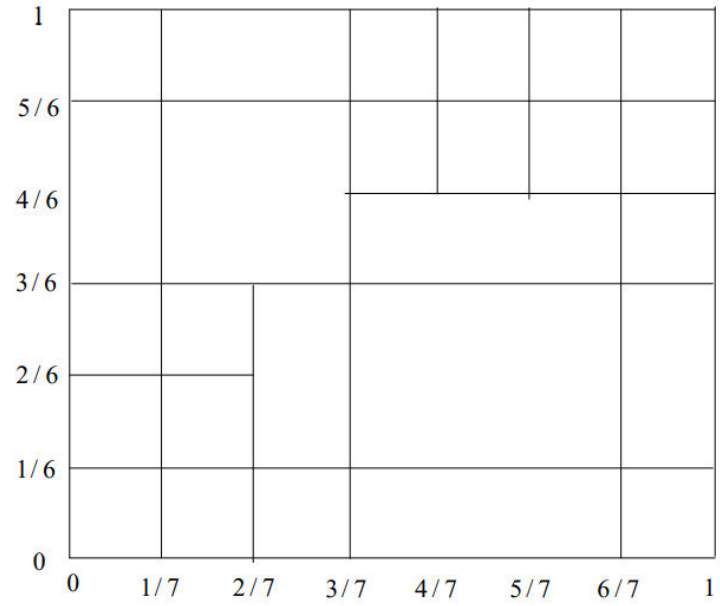
Figure 6. The first example.